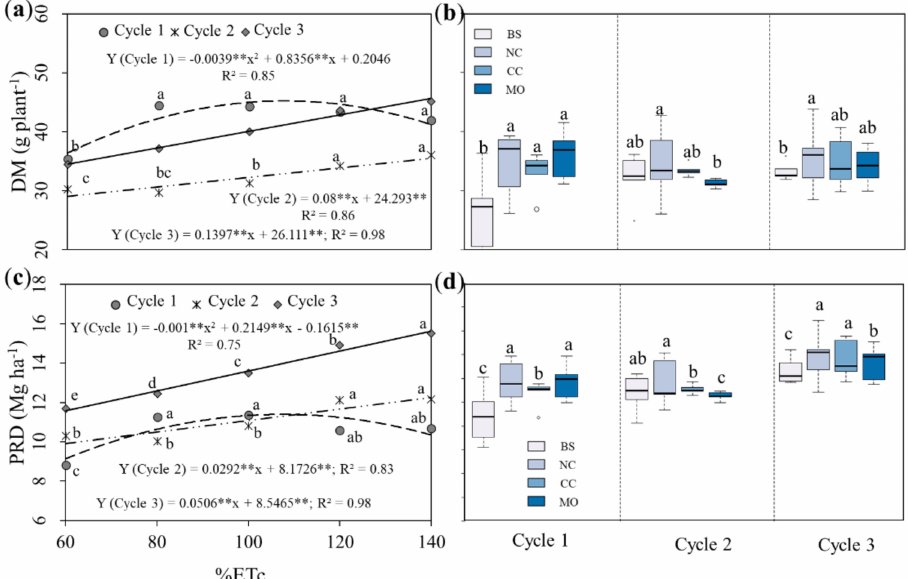
Figure 6. Dry mass (DM) ( a ) and productivity (PRD) ( c ) of sorghum as a function of irrigation depths using wastewater. Box plot for DM ( b ) and PRD ( d ) under different soil cover conditions. Mean values were compared using Tukey’s test ( p < 0.05) and are indicated by lowercase letters. The significant regression coefficients are for p < 0.01